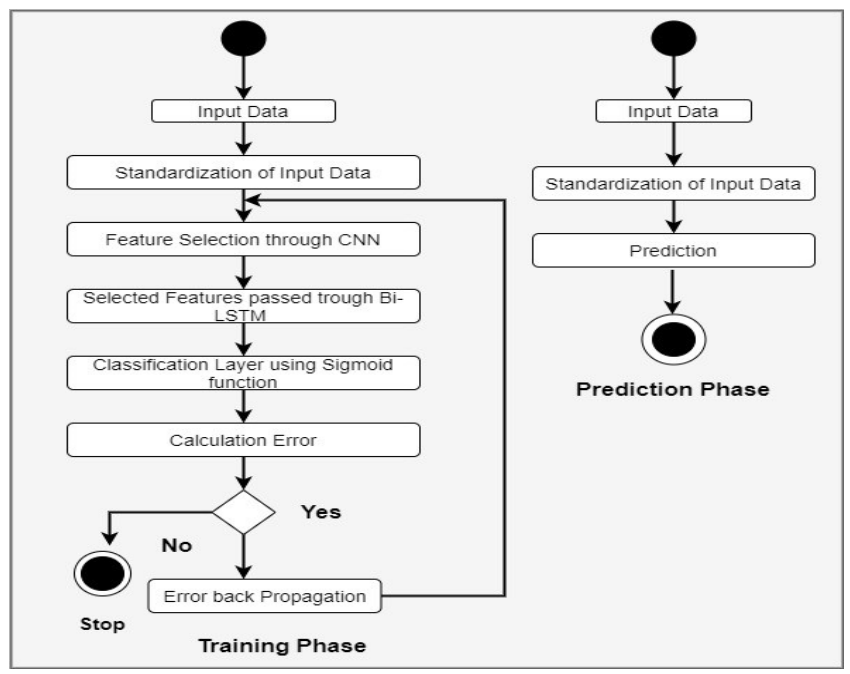
Figure 7. Activity diagram for CNN-Bi-LSTM Model.